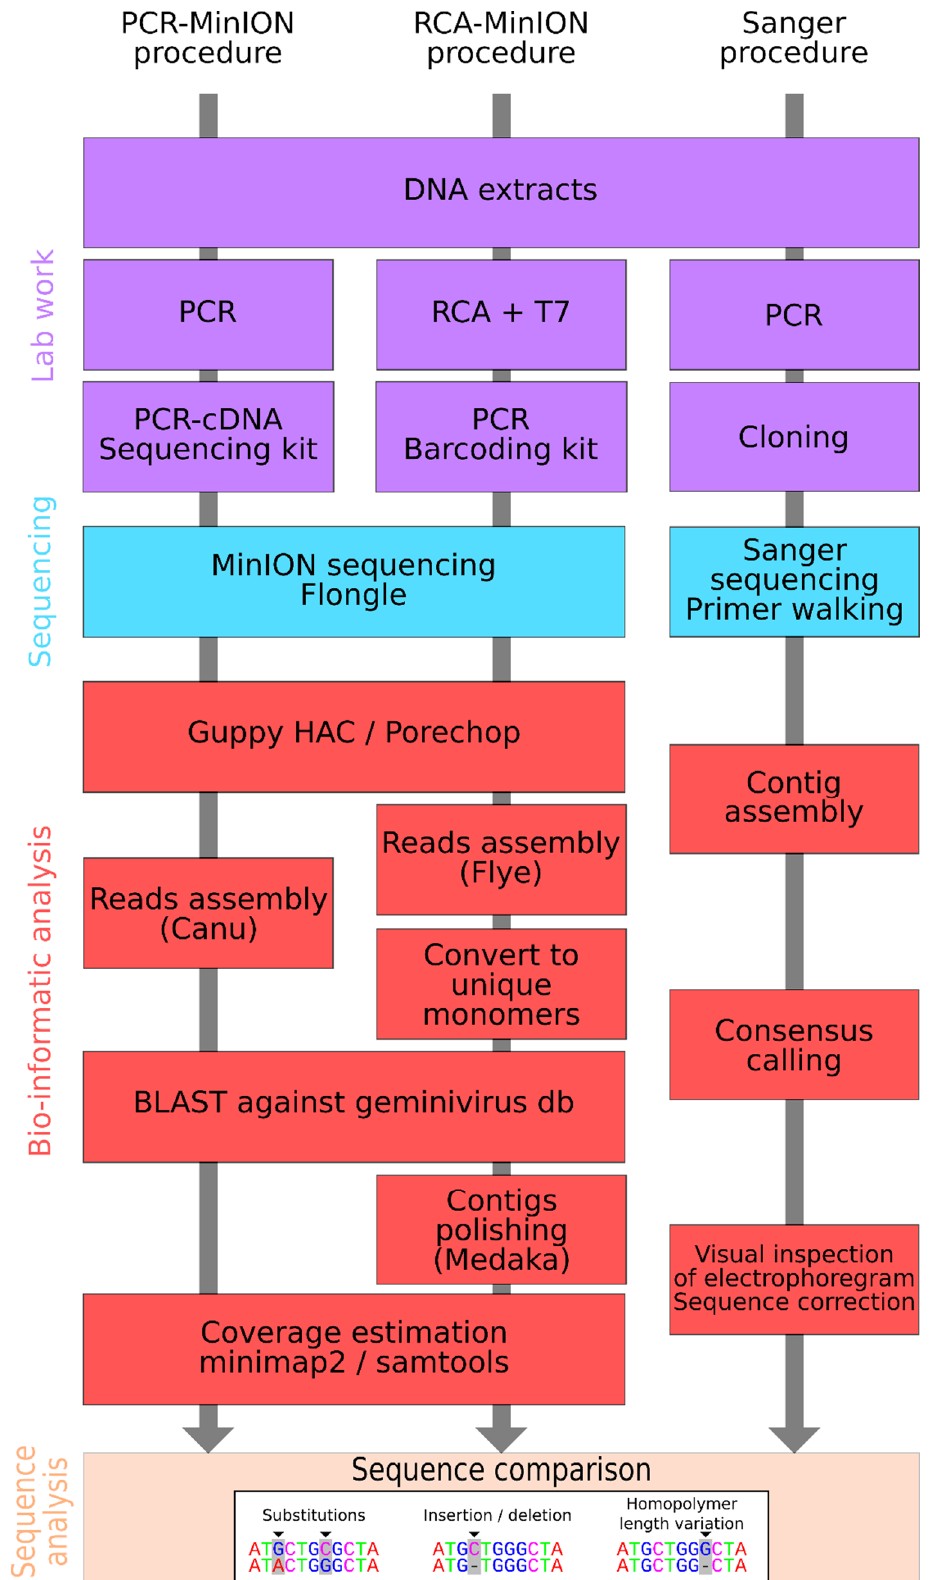
Figure 1. Schematic representation of the three distinct sequencing methodologies used including the molecular biology procedure (purple boxes) the sequencing procedure (light blue boxes), the bio-informatics procedure (red boxes) and the method comparison (orange boxes).